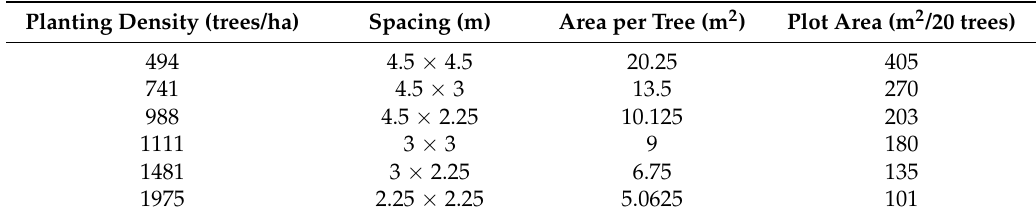
Table 2. Initial planting density, spacing between trees, area occupied per tree and plot area. Planting Density